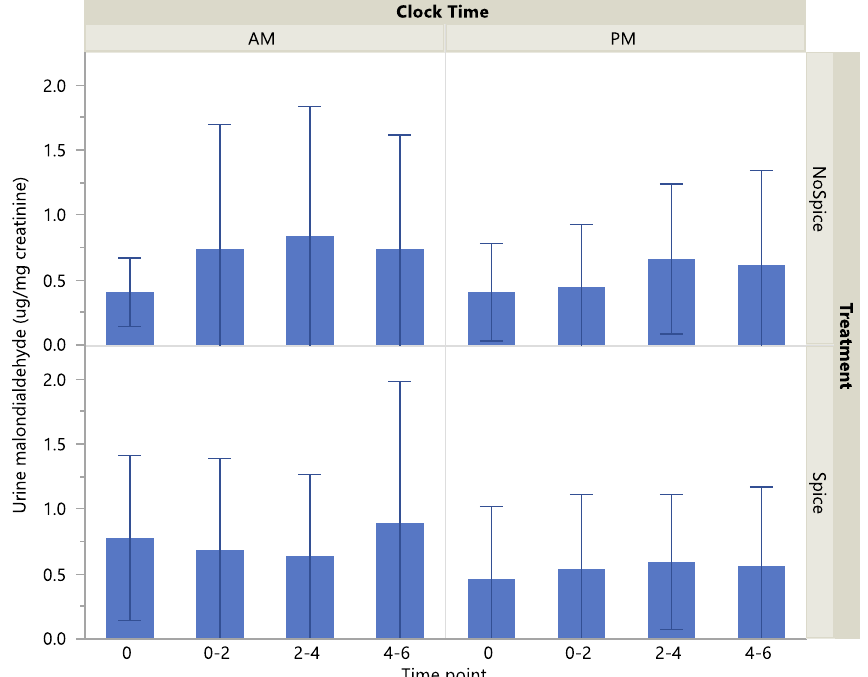
Figure 3. Urine malondialdehyde concentrations by treatment, clock time and time point. Values are means with standard deviation. Effect of treatment, p > 0.05; clock time, p < 0.01; time point, p < 0.05.